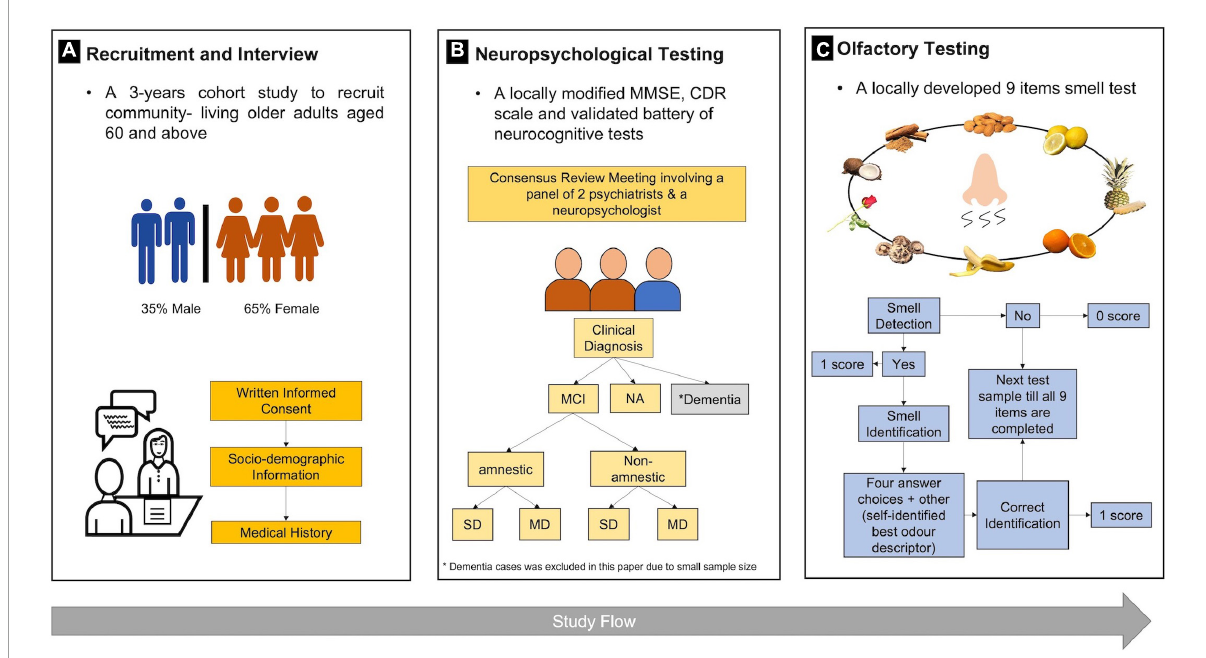
FIGURE1 Study procedures for 670 older adults in (A) recruitment, (B) neuropsychological tests, and (C) olfactory testing. MMSE, Mini-Mental State Examination; CDR, clinical dementia rating; MCI, mild cognitive impairment; NA, normal aging; SD, single domain; MD, multiple domain.